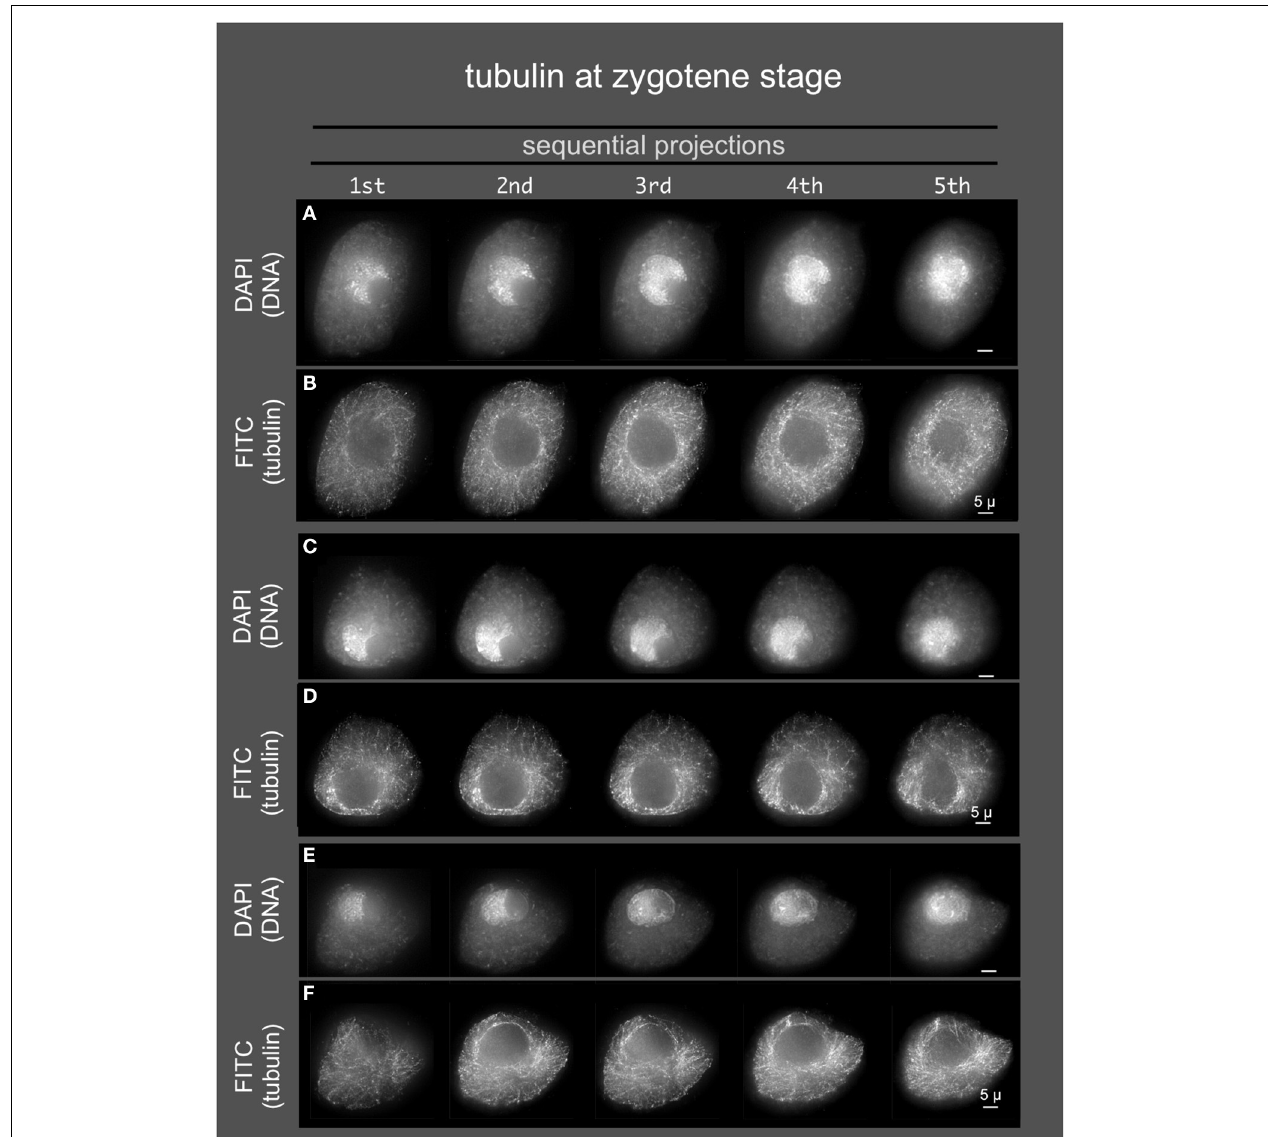
FIGURE 4 | Microtubules in early meiotic prophase (zygotene stage). Anthers from maize inbred line A344 were fixed and dissected meiotic cells were embedded in acrylamide gels for immunostaining using TUB2.1